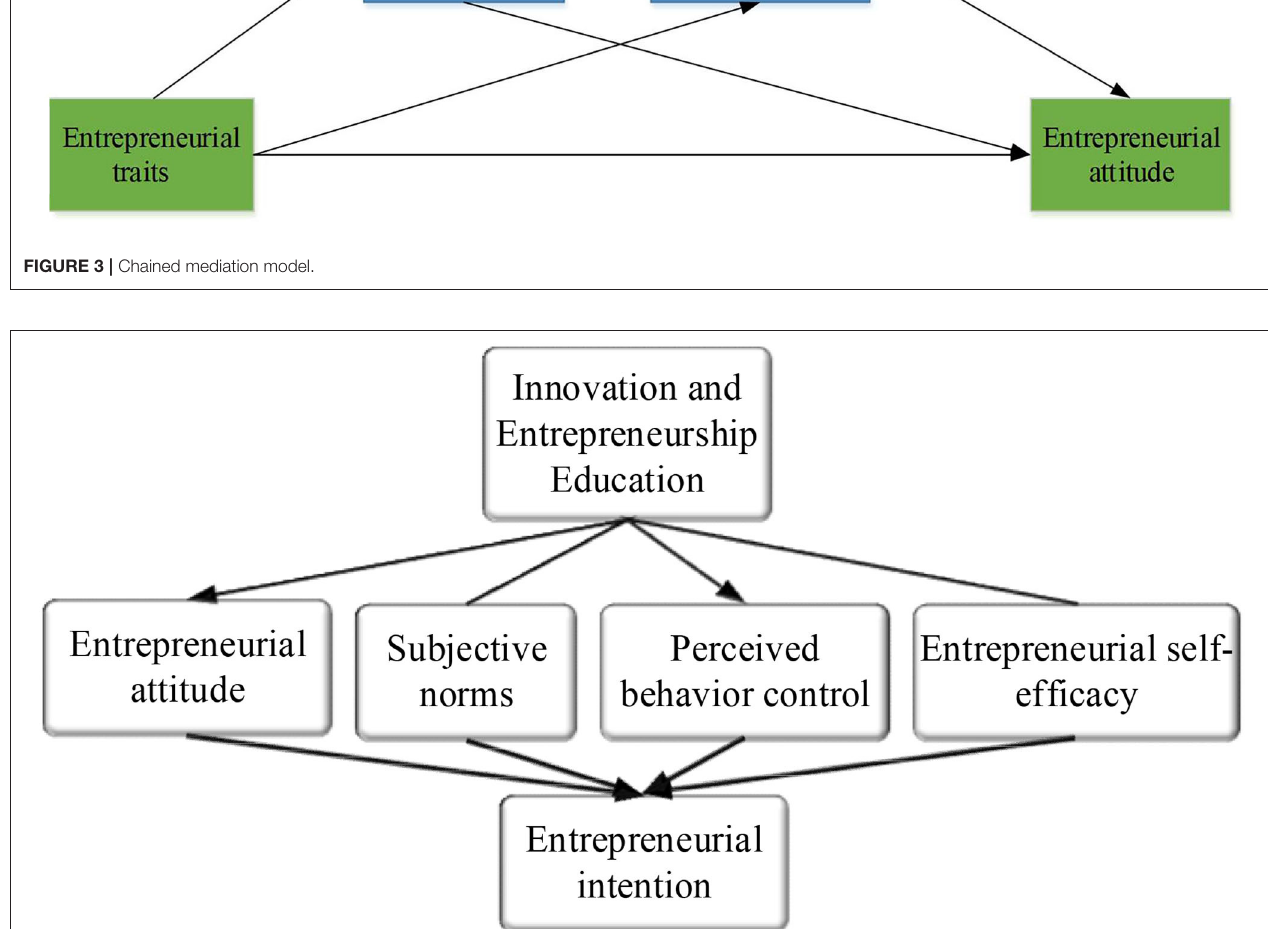
FIGURE 4 | Path map of the mediating